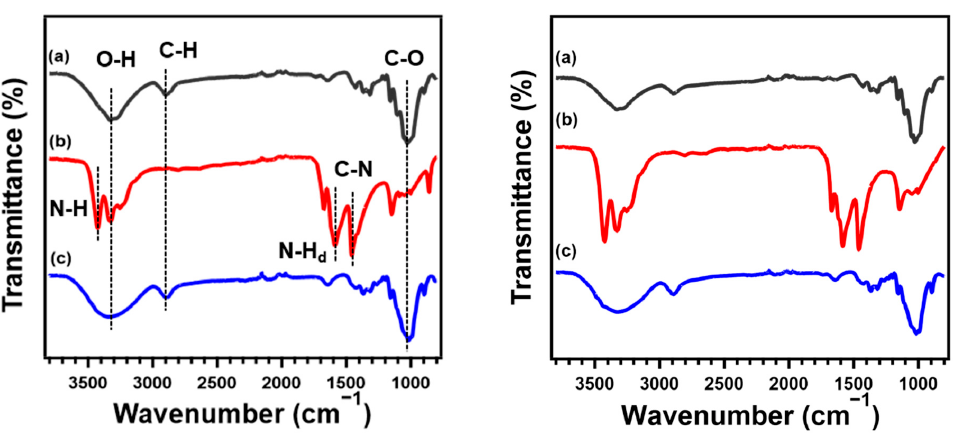
Figure 3. FT-IR spectra of ( a ) native cellulose, ( b ) dried mixture composed of cellulose, LiOH, and urea, and ( c ) regenerated cellulose film regenerated with methanol based on CNF ( left ) and MCC ( right ).